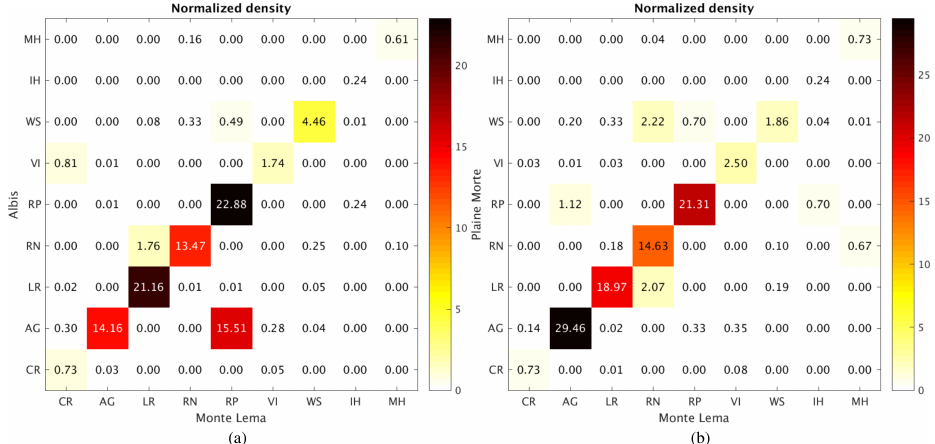
Figure 7. Matching matrix of the classification results obtained with Monte Lema data with the Monte Lema centroids opposed to the classifications results obtained with the same data but with the centroids of (a) Albis and (b) Plaine Morte. The results are averaged over the entire duration of the convective event that occurred in the proximity of Monte Lema radar site on 12 June 2014.